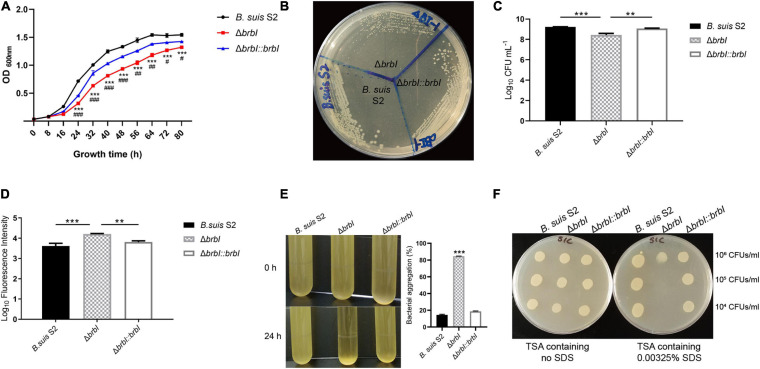
Physiological phenotypes of the ΔbrbI strain. (A) Growth characteristics of the ΔbrbI strain in TSB. “*” Indicates comparison of the B. suis S2 and ΔbrbI strains; “#” indicates comparison of the ΔbrbI::brbI and ΔbrbI strains. (B) Growth characteristics of the ΔbrbI strain on an antibiotic-free TSA plate. (C) Viable bacterial concentrations in the three B. suis S2 strains with the same OD600 nm. The Brucella samples were adjusted to the same OD600 nm, then the concentrations of viable bacteria from each sample were measured by plating them onto TSA plates. (D) Fluorescence intensity of the three B. suis S2 strain samples containing the same number of bacteria. Three B. suis S2 strain samples containing 2 × 107 CFUs each were taken and stained with PI, then the fluorescence intensity of each sample was measured. (E) Bacterial aggregation phenotype of the ΔbrbI strain. The three B. suis S2 strains were harvested at the exponential phase and left standing at room temperature for 24 h. The OD600 nm of 100 μl of the culture obtained before and after standing was measured to quantify the bacterial aggregation. (F)
brbI deletion increases the sensitivity of B. suis S2 to SDS. Ten μl of Brucella samples were added to a TSA plate containing 0.00325% or no SDS and incubated for 24 h at 37°C. The data are expressed as the mean ± SD of representative experiments performed in triplicate and analyzed using one-way ANOVA with Tukey’s post-test. #p < 0.05,∗∗/##p < 0.01, ***/###p< 0.001.